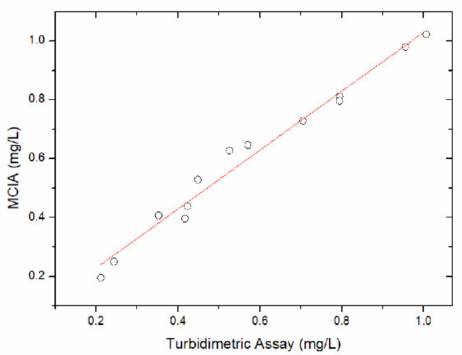
Figure 6. The correlation between the turbidimetric assay and the MCIA (n = 13).